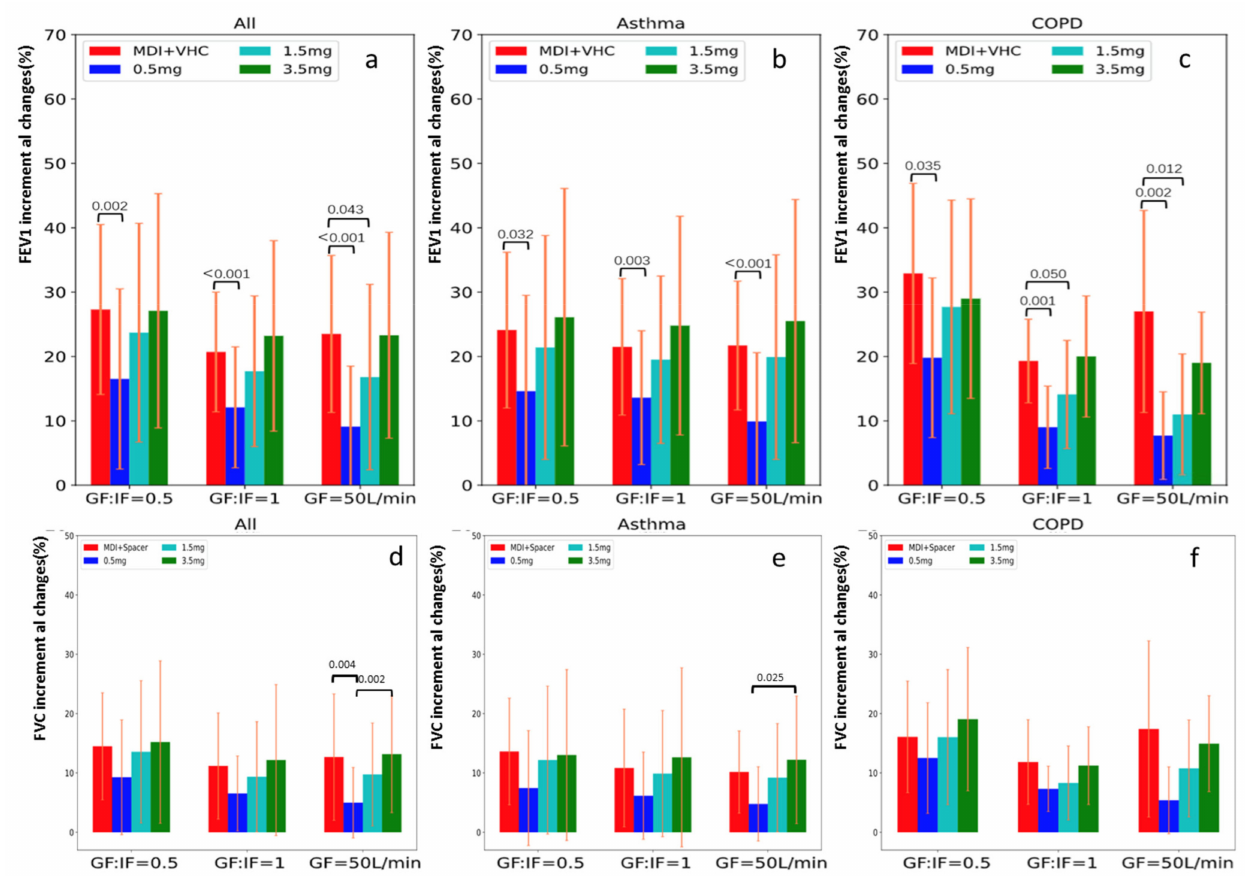
Figure 3. FEV 1 and FVC improvement after inhaling salbutamol during screening (MDI + VHC) and via HFNC at different nominal doses in three groups. Using the FEV 1 improvement after inhaling salbutamol at each cumulative dose to compare that with screening (ANCOVA test), screening FEV 1 post-salbutamol improvement was higher than FEV 1 improvement after inhaling salbutamol at 0.5 mg via HFNC in all three groups, however, this difference became non-significant at the cumulative dose of 1.5 mg via HFNC, except for those receiving GF = 50 L/min, the difference became non-significant at the cumulative dose of 3.5 mg ( a ). For asthma subjects, the difference of FEV1 improvement from screening became non-significant at the cumulative dose of 1.5 mg for all three flows ( b ). In contrast, for COPD subjects, post-bronchodilator FEV1 improvement was similar at 1.5 mg only with flow of GF:IF = 0.5, the differences became insignificant at 3.5 mg with flows of GF:IF = 1.0 and GF = 50 L/min ( c ). Compared to FVC improvement salbutamol via MDI + VHC during screening, no significant differences of FVC improvement in the inhalation of all doses of salbutamol via HFNC, except for the lower improvement of FVC after inhaling 0.5 mg of salbutamol via HFNC in the group of GF = 50 L/min ( p = 0.004) ( d ). Similar responses in FVC for asthma ( e ) and COPD ( f ) subjects. HFNC, high-flow nasal cannula; FEV 1 , forced expiratory volume in the first second; MDI, metered dose inhaler; VHC, valved holding chamber; GF, gas flow; IF, inspiratory flow; COPD, chronic obstructive pulmonary disease; FVC, forced vital